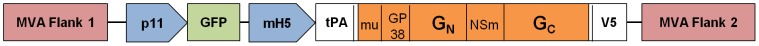
Schematic representation of the vaccine vector.Nucleotides 34 to 5082 of the CCHFv M segment (orange) were fused at the amino-terminus to the 36 amino acid residue tPA leader sequence, via 11 residues derived from the Gateway recombination process. The carboxy-terminus was fused to the 14 amino acid residue V5 epitope, via 11 residues of Gateway sequence, and 8 residues of a linker peptide. This product was under the control of the mH5 promoter, and between MVA flanks for insertion into the Deletion III site of the MVA genome. The insertion cassette also contained the enhanced GFP gene downstream of the p11 promoter, for identification of recombinant virus. The mucin-like domain is represented by ‘mu’.